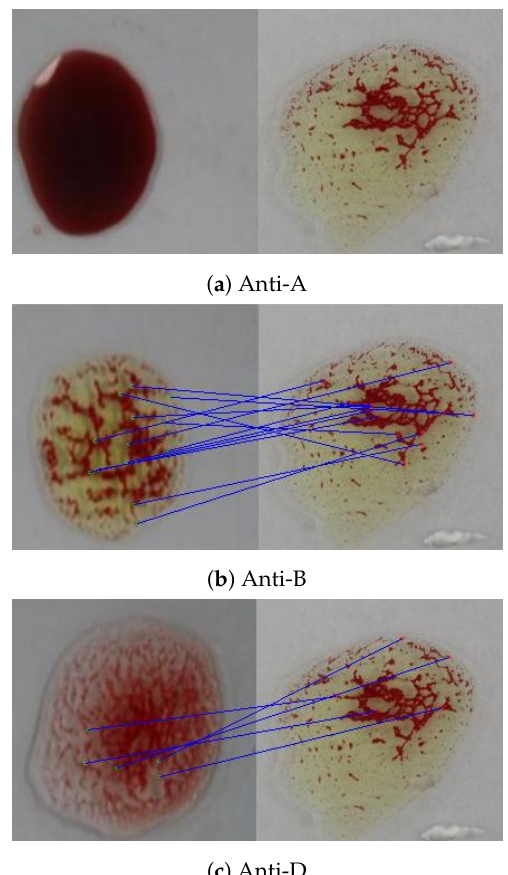
Figure 19. Feature points matching between a blood sample and the reference image for the three blood spots (anti-A, anti-B, and anti-D) using the ORB